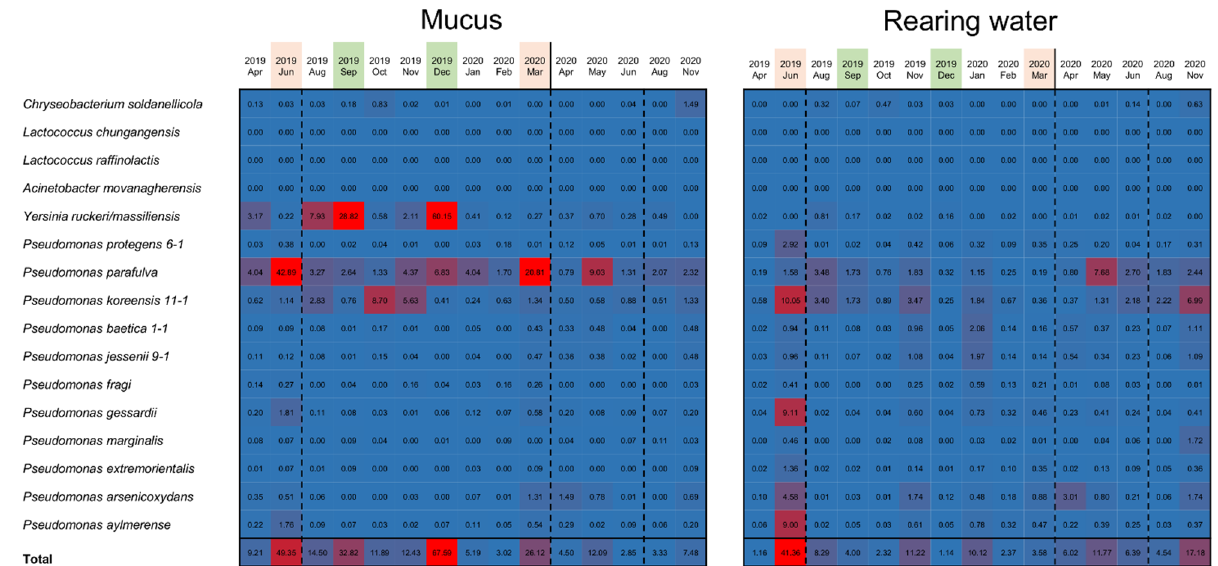
Figure 5. Confirmation of antimicrobial bacteria species in the epidermal mucus and rearing ponds of rainbow trout. Sequence reads randomly sampled from the data of each month (skin mucus samples and water samples) were mapped on the sequence list of the 16S rDNA V1–V2 region of antimicrobial bacteria isolated from the skin mucus samples. The number of reads mapped on the sequence for each antimicrobial bacteria was counted, and the proportion (%) of the mapped reads for each bacterium is presented as a heatmap (number of reads per total reads mapped on each bacterium). The months of observed disturbances of the flora are represented by pink, and occupation of the flora is represented by green.